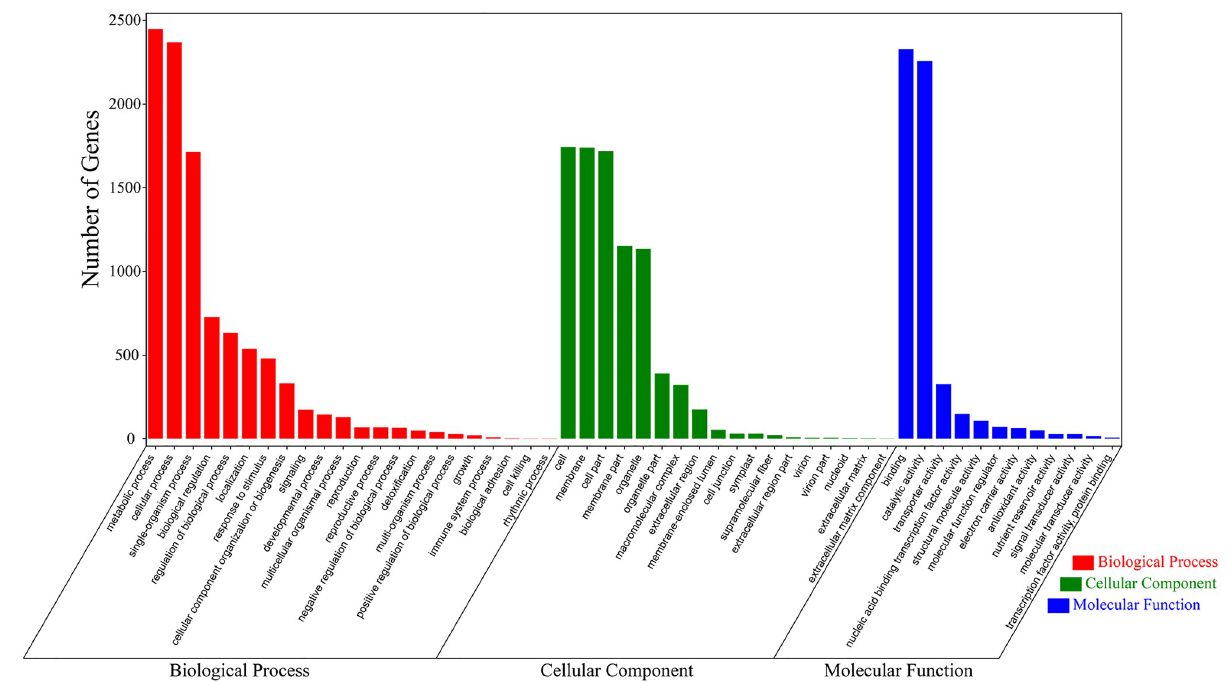
Fig 4. GO classification performed in the transcriptome sequencing